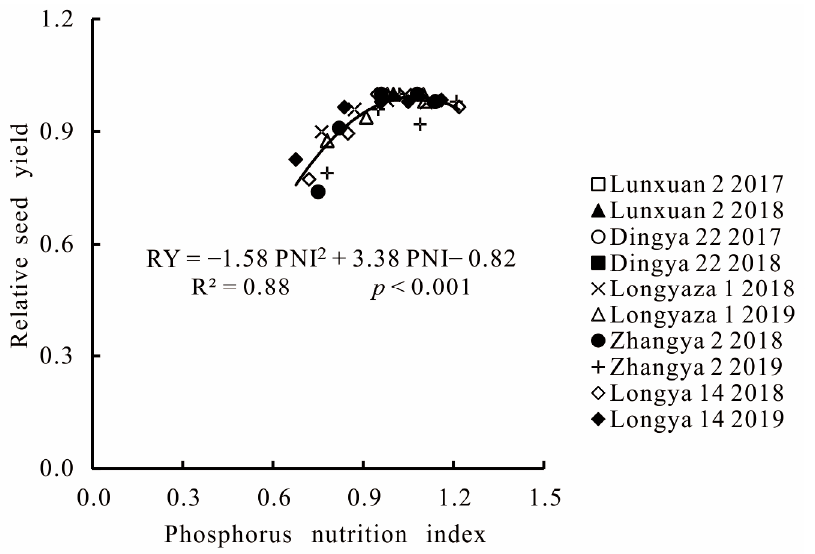
Figure 2. Relationship between relative seed yield (RY) and phosphorus nutrition index (PNI) with five flax cultivars. The PNI data were averaged over three years and two sites.